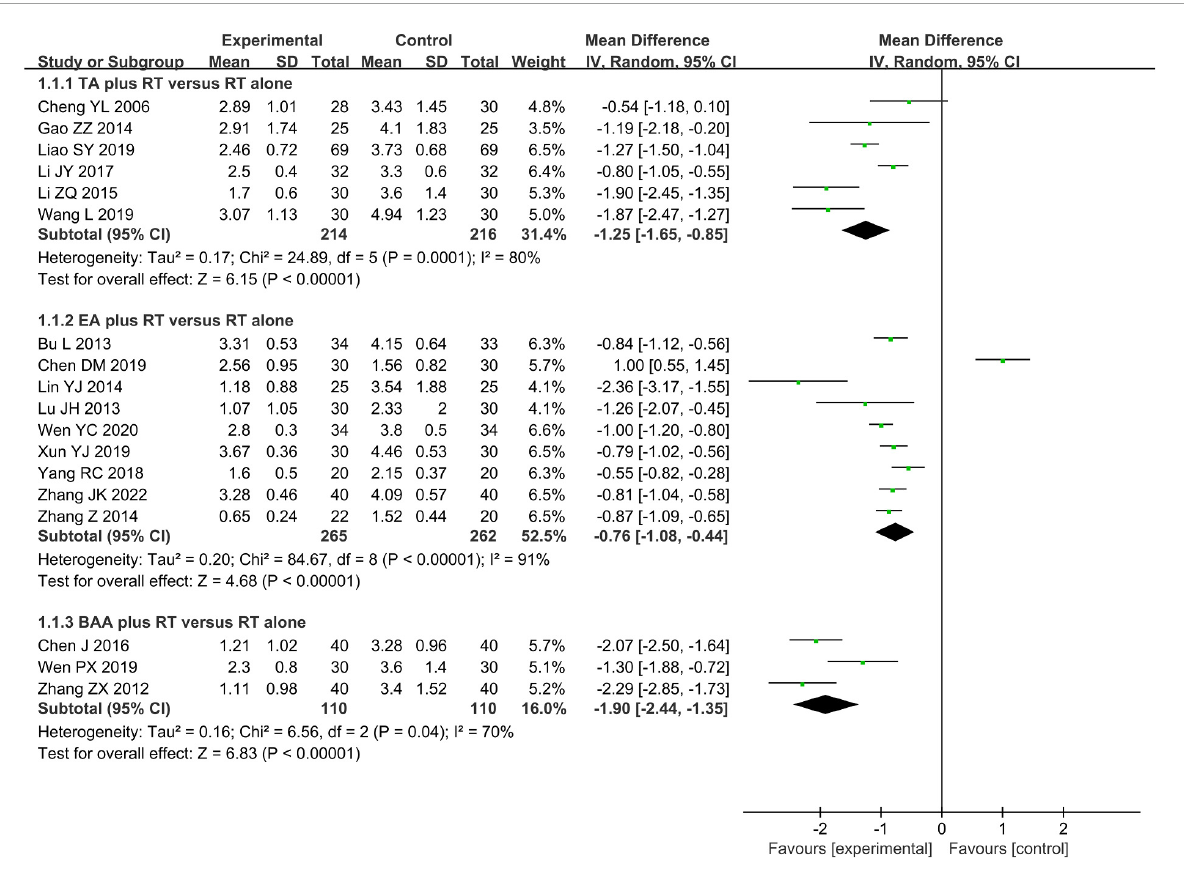
FIGURE8 Forest plot and subgroup meta-analysis of VAS (BAA, balancing acupuncture; EA, electroacupuncture; RT, rehabilitation training; TA, traditional acupuncture; VAS, visual analog